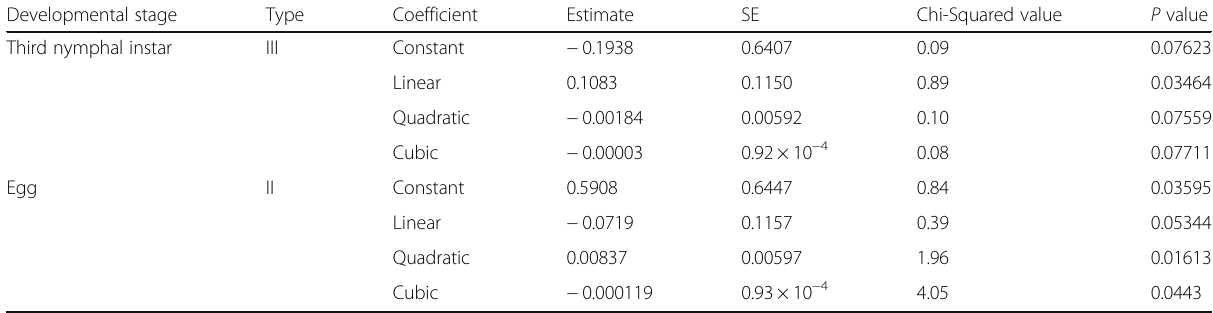
Table 1 Maximum-likelihood estimates from logistic regressions of the proportion of Bemisia tabaci eggs and third instar nymphs eaten by Orius albidipennis on initial prey density Developmental stage Type